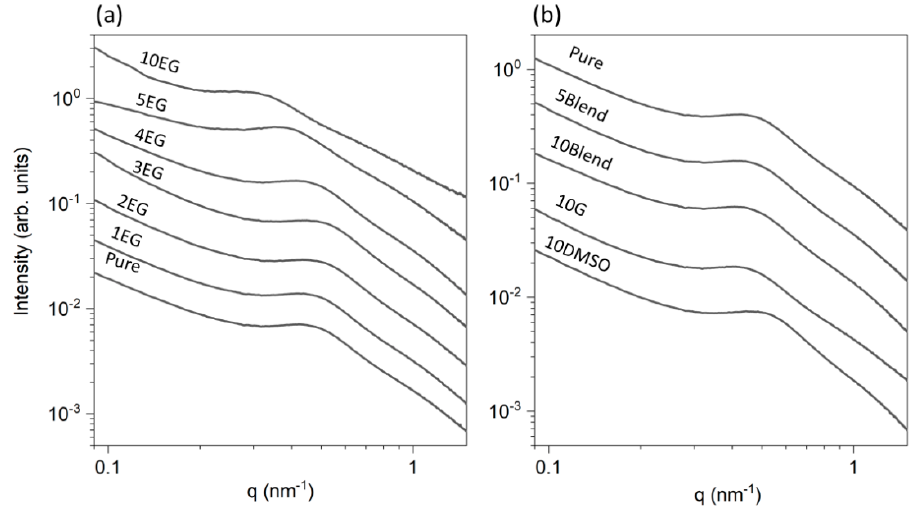
Figure 1. SAXS intensity profiles of PEDOT:PSS ( a ) with EG and ( b ) with G, with DMSO and the blend G+DMSO, at different wt% as labeled. X-axis and Y-axis are presented in logarithmic scale. The profiles are shifted vertically for clarity.